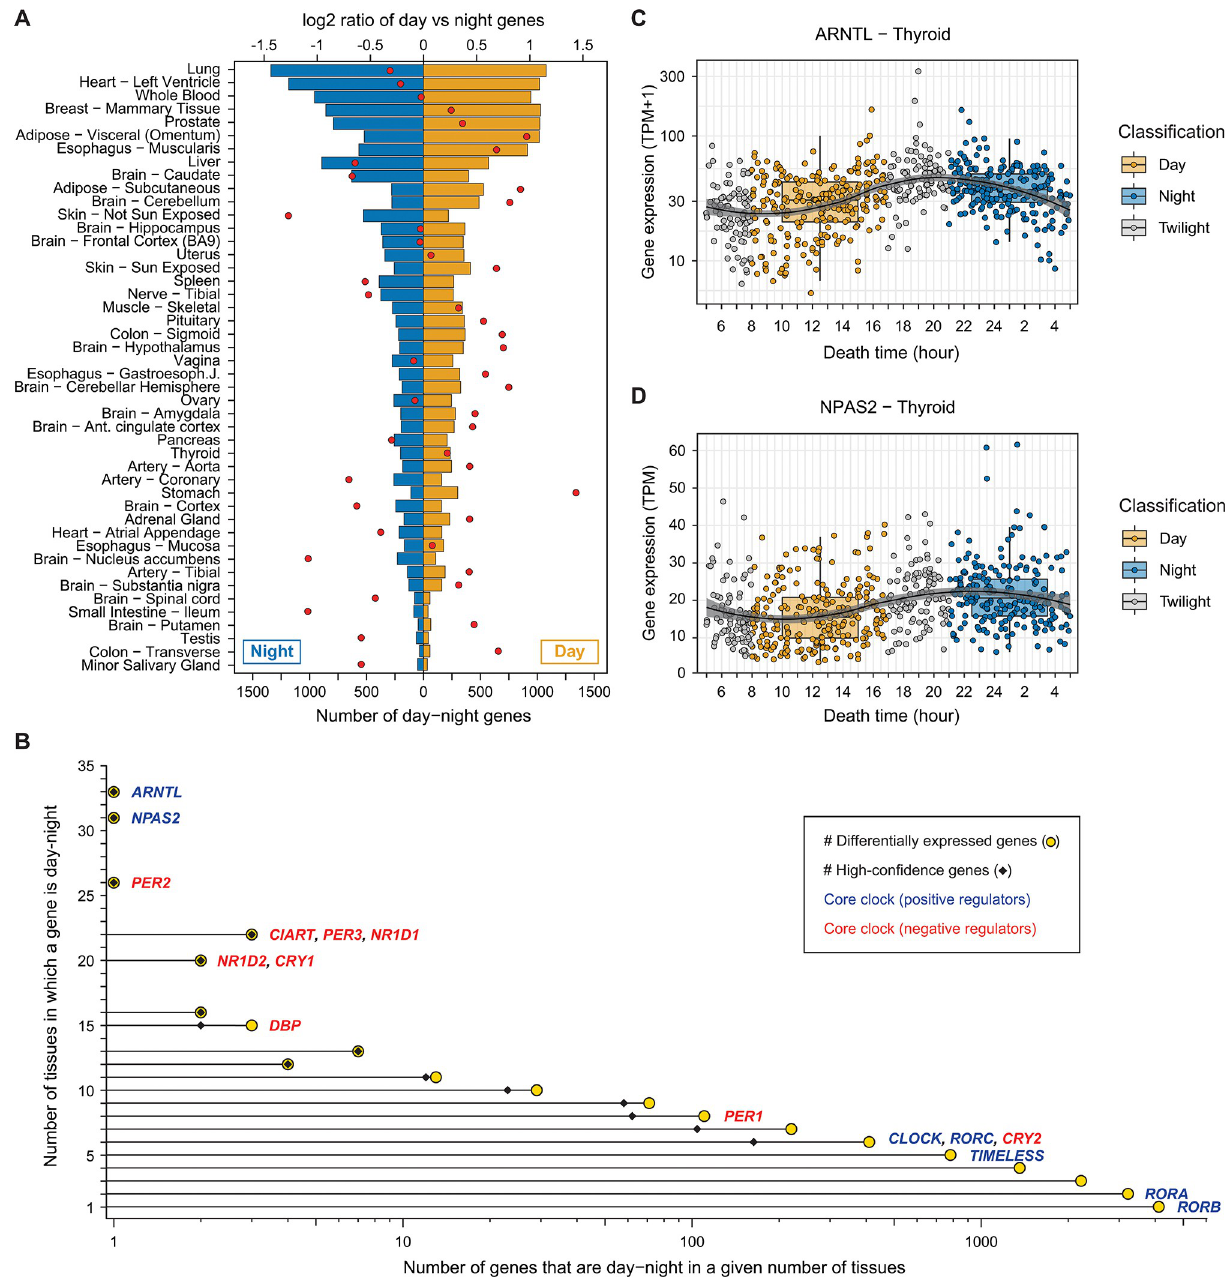
Fig 2. Distribution of the day-night genes in the GTEx tissues. ( A ) Number of genes found as day-night, i.e., genes differentially expressed between day and night (barplots; bottom x-axis), and log 2 ratio between the number of genes up-regulated during the day vs. the night (red dots; top x-axis) for each tissue. Tissues are sorted by the total number of day-night genes. ( B ) Yellow dots represent the number of tissues in which a given gene is classified as day-night (y-axis) vs. the number of genes that are classified as day-night in that number of tissues (x-axis, log genes are shown next to the dot with the corresponding number of tissues in which they are identified as day-night. Black diamonds show the number of high-confidence day-night genes per number of tissues (see S5 Fig for further details). ( C ) Expression of ARNTL in the thyroid in GTEx samples at the time of death of the GTEx donors (in hours). The colors of the dots represent the classification of the individuals according to their time of death: during the day (yellow), during the night (blue), or during twilight (grey). The samples classified as twilight were discarded for the day-night analysis. The “circadian” curve was created using the geom_smooth function from ggplot2 in R with the “loess” method. The data underlying this figure can be found in S1 Data.